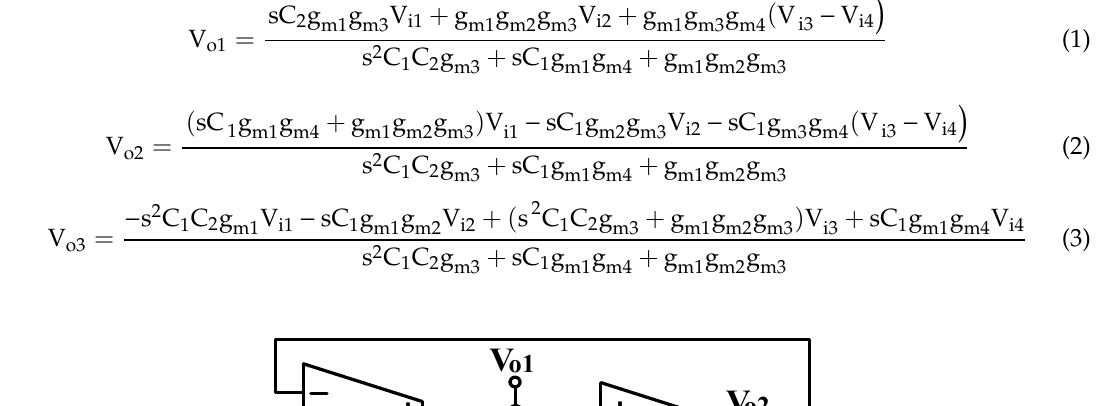
Figure 3. Proposed versatile VM biquad.